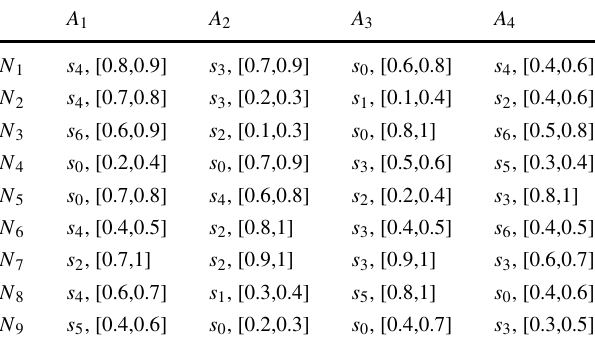
Table 8 The decision matrix with confidence interval values according to the seventh voting